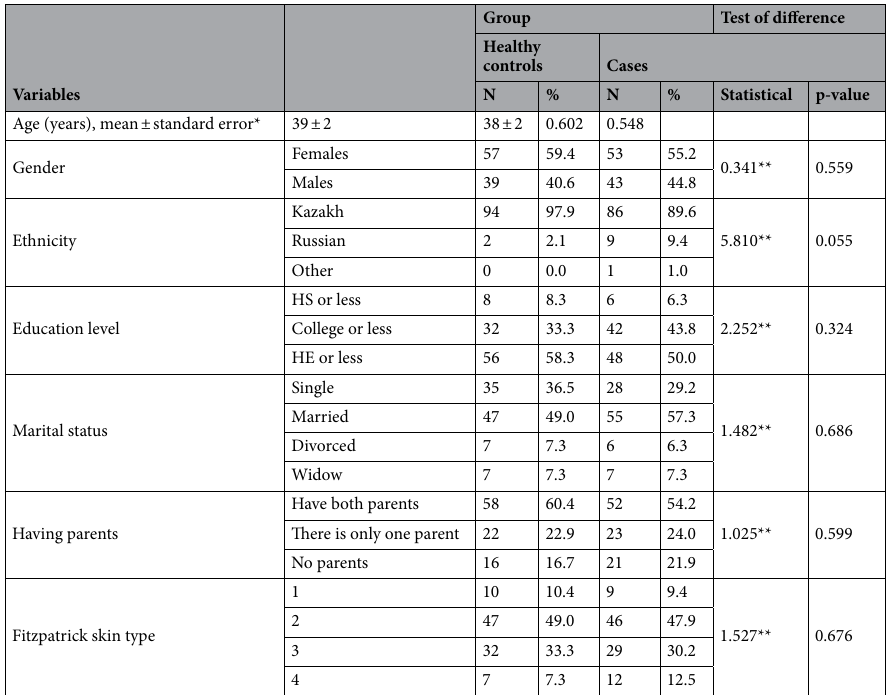
Table 1. Baseline characteristics in subjects with vitiligo and healthy control groups. *Test of difference was t-test. **Test of difference was Chi-square test. HS—Higher School; HE—Higher Education.